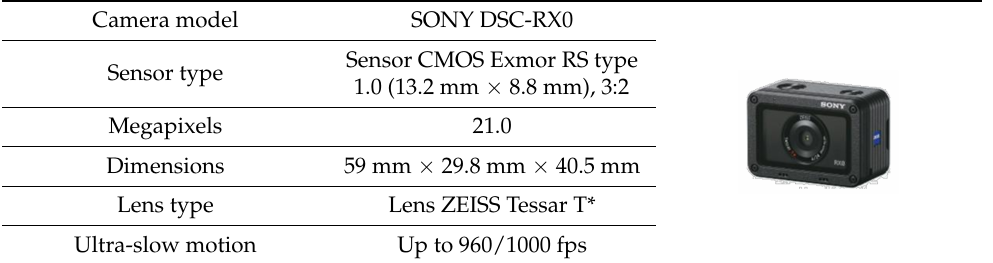
Table 2. Technical information of the